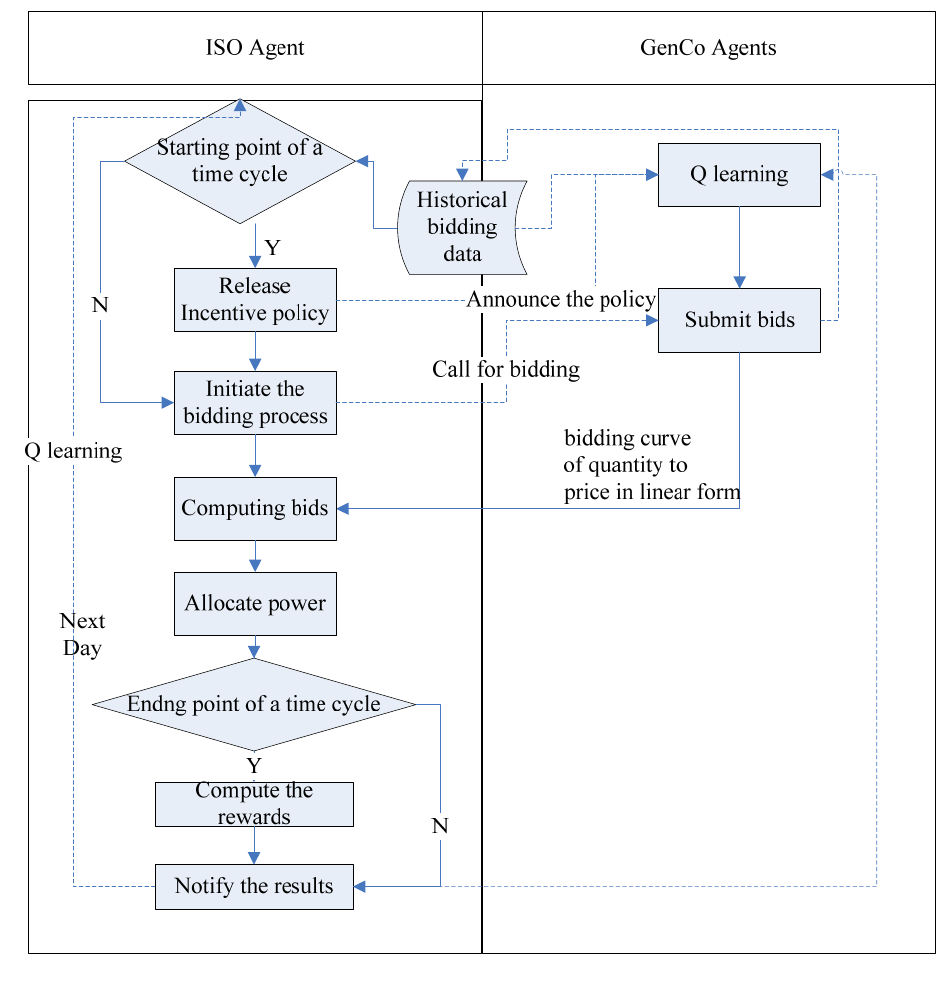
Figure 2. Flow chart of multi ‐ agent system (MAS) scheduling mechanism (note: Y = yes and N = no). ISO: independent system operator.